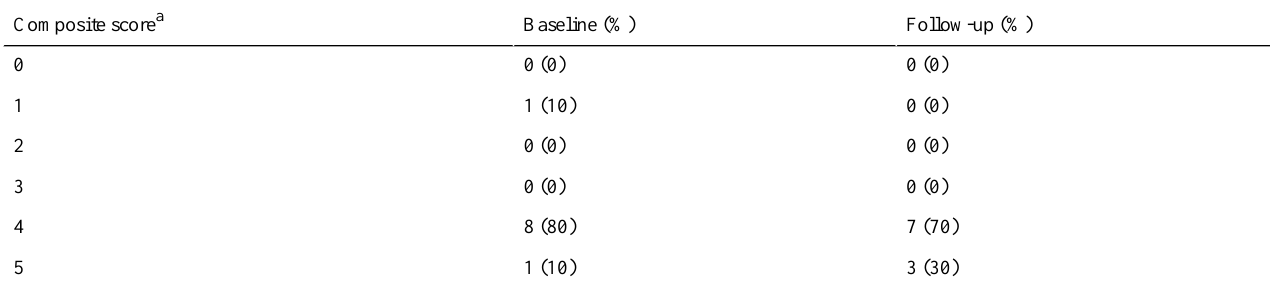
Table 3. Frequency of pre-exposure prophylaxis (PrEP) composite adherence scores at study baseline and follow-up visits.